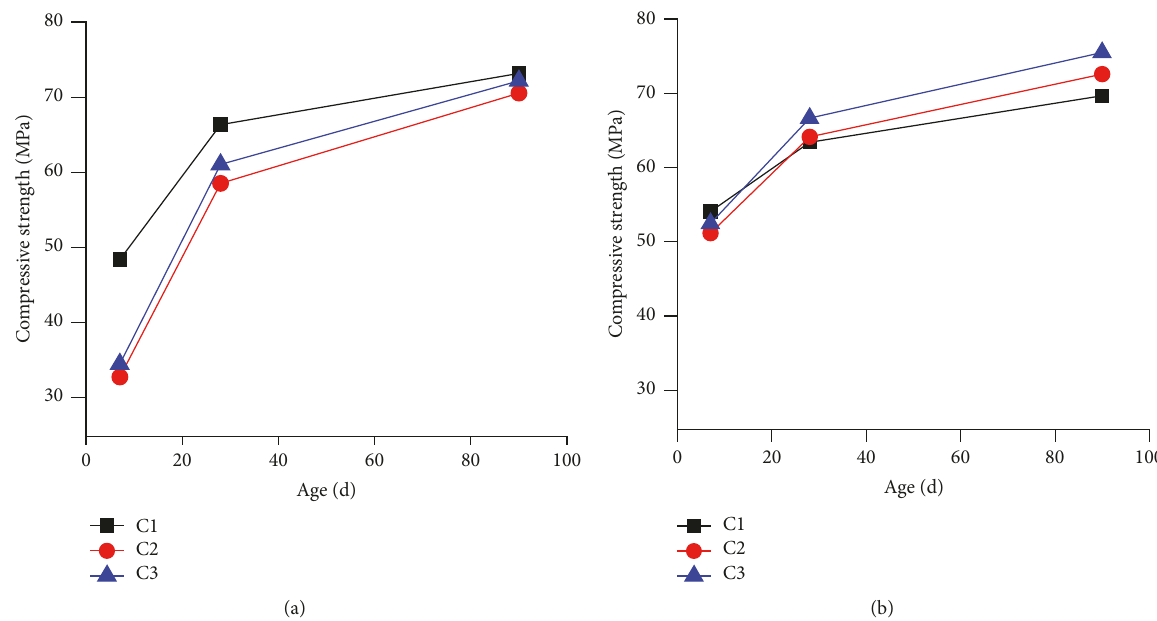
Figure 5: (a) Compressive strength of concrete for standard curing. (b) Compressive strength of concrete for temperature match curing.